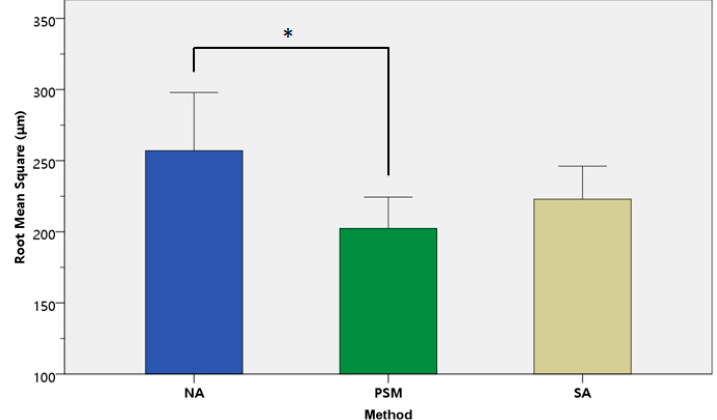
Figure 6. The RMS values outside of the tolerance area. Asterisks (*) indicate significant differences in the RMS values between groups in the post hoc analysis. NA, the group with no adjustment; PSM, the group adjusted using Patient Specific Motion; SA, the group adjusted with a semi-adjustable articulator; RMS, root mean square.